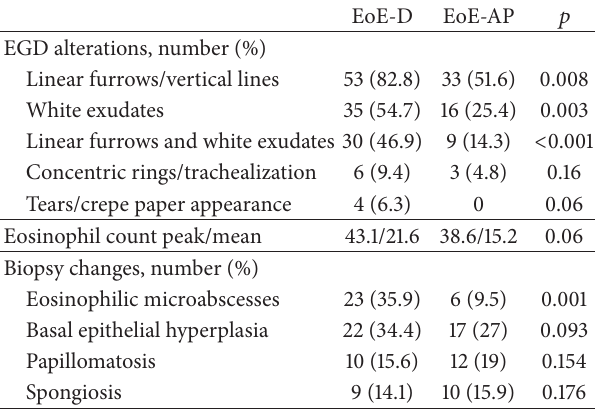
Table 2: EGD and biopsy findings of